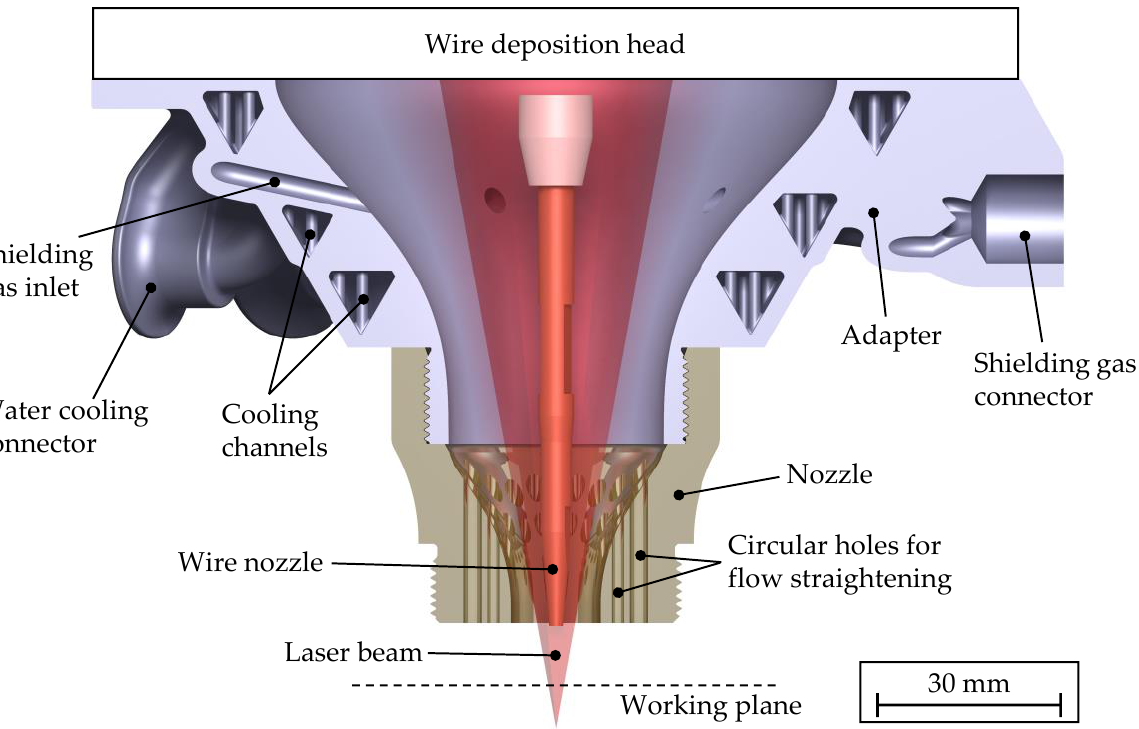
Figure 4. Cross-sectional view showing the final computer-aided design model of the shielding gas device with the various design features.